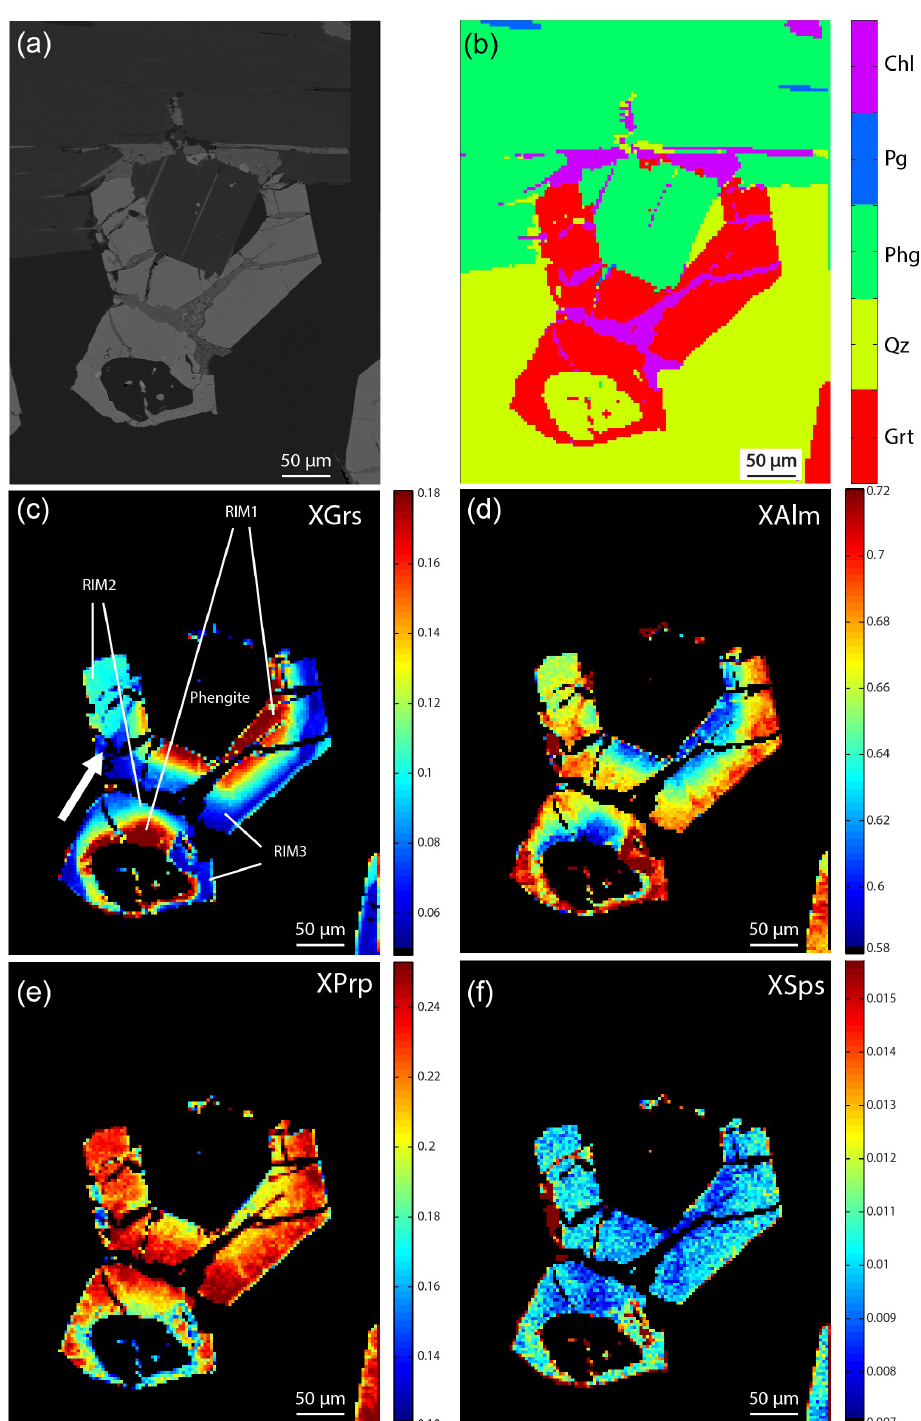
Figure 5. Small atoll garnet (ø ∼ 100µm) in sample FG1315. (a) BSE picture. (b) Mineral phases (determined from X-ray maps). Note inclusions of quartz and phengite in the atoll core; fractures dissecting the entire garnet are filled by chlorite. Garnet occurs at the contact of quartz- and phengite-rich bands that define the main foliation. (c) Standardized X-ray map for the X Grs endmember. Note the analogous zoning pattern as for large garnet (Fig. S5), with the same X Grs contents and a Rim3 peninsula extending into the resorbed rims (arrow). (d–f) Standardized X-ray maps for X Alm , X Prp , and X Sps , respectively.